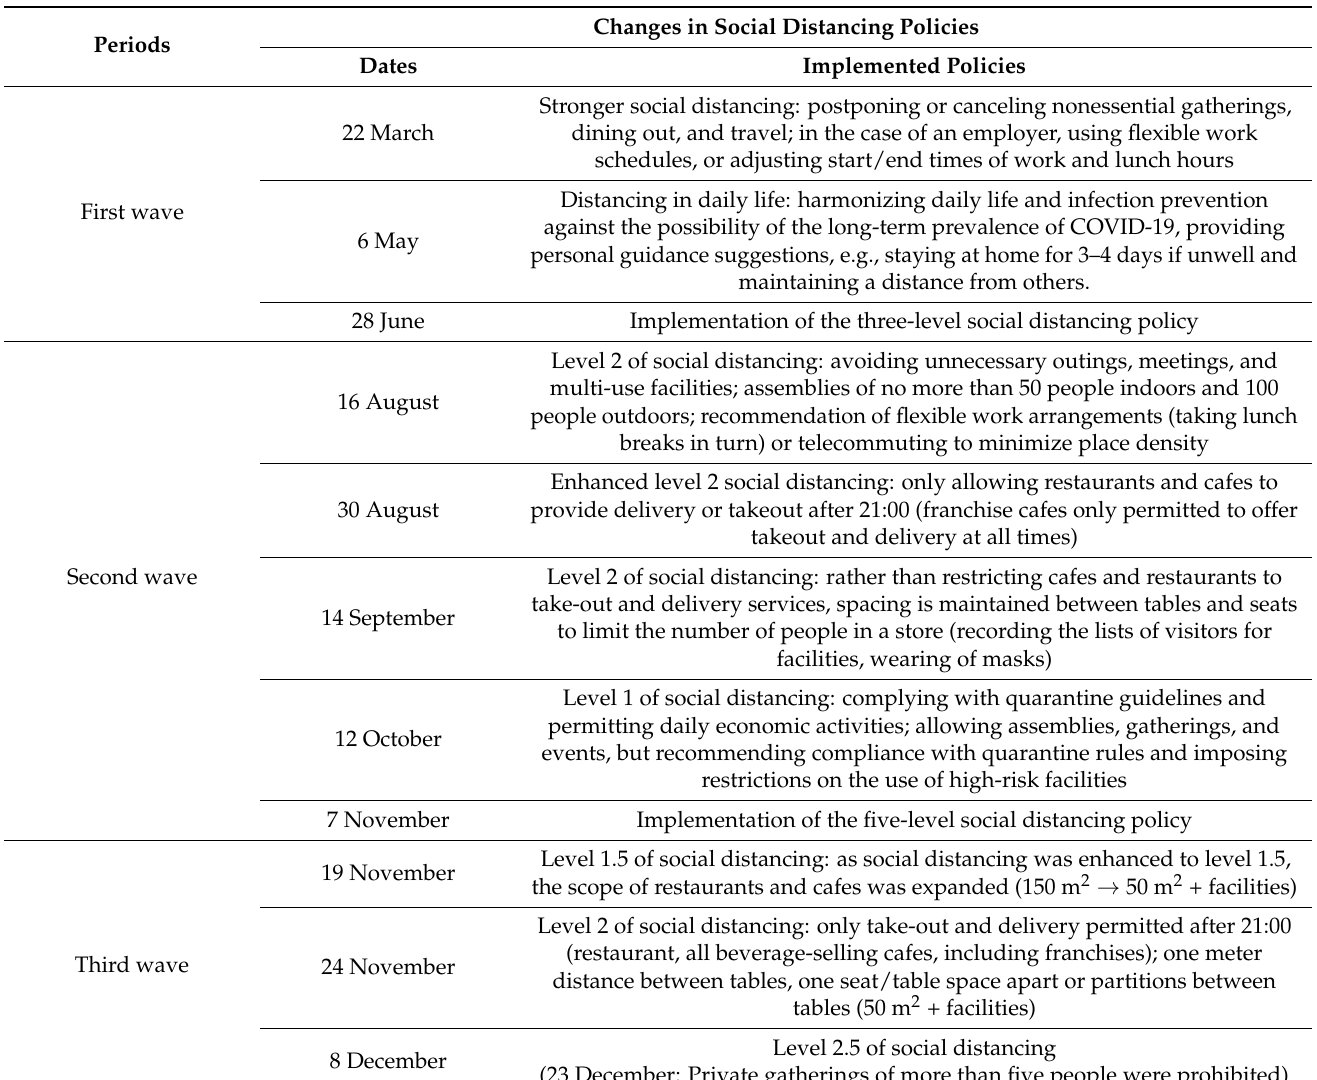
Table 1. Implementation of social distancing policies in Seoul,